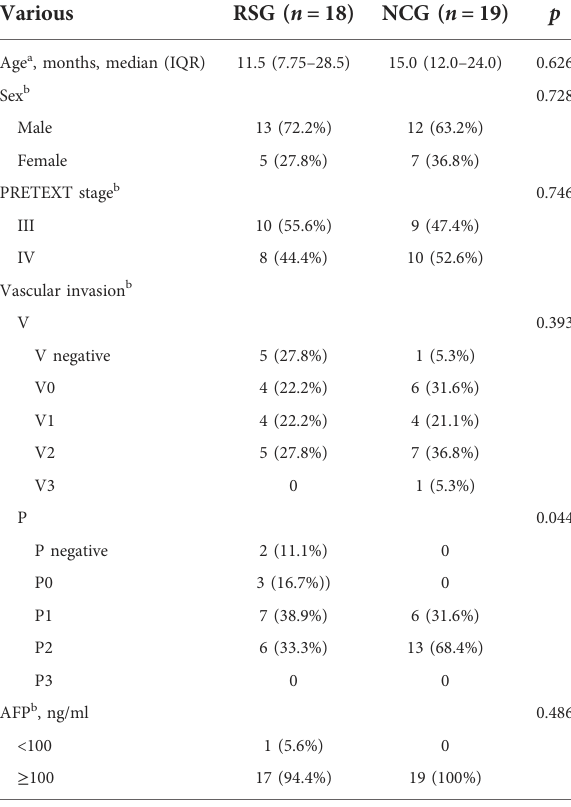
TABLE 2 Clinicopathological data of the two groups. TABLE 3 Comparison of chemotherapy complications between the two groups.